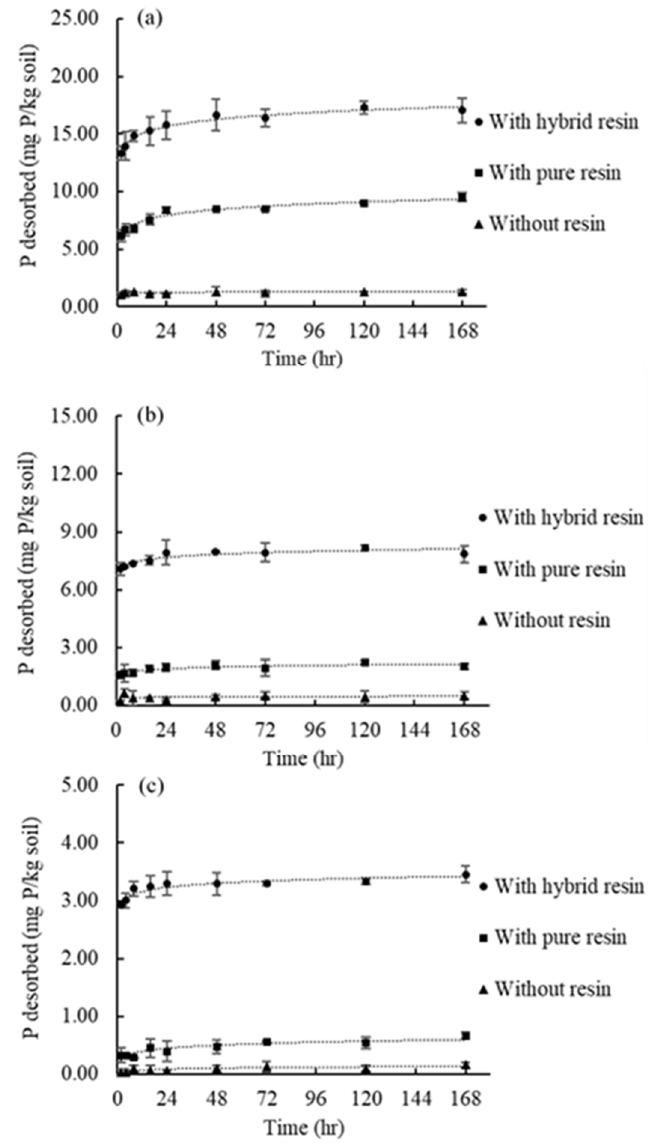
Figure 5. Phosphate desorption kinetics from soils ( a ) S_18, ( b ) S_90, and ( c ) S_180 in different desorption systems.